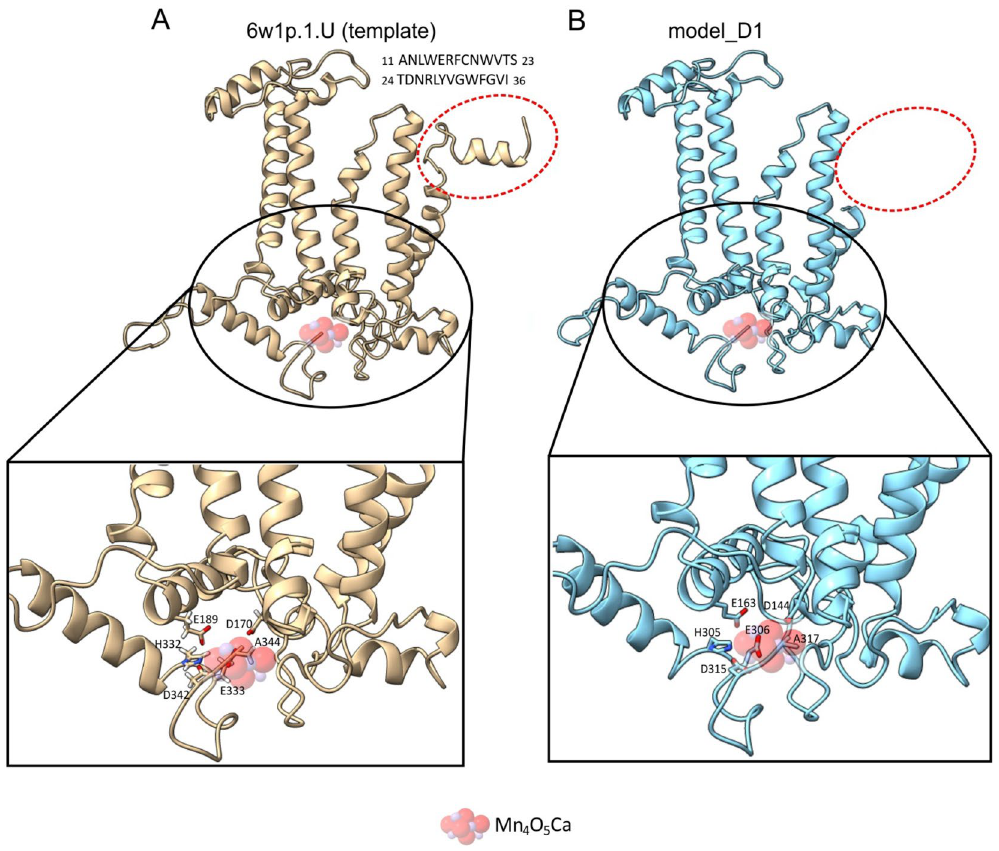
Figure 2. The predicted 3D structure of the ancestral D1 protein. ( A ) The structure of the template sequence from T. elongatus (PDB: 6w1p.1.U). ( B ) The structure of the predicted D1 protein (model_D1). Shown is the 26 amino acid sequence by which the two structures differ. The Mn 4 O 5 Ca cluster and its binding amino acid residues are shown. The 3D protein structures were visualised and analysed using UCSF ChimeraX software 31 .